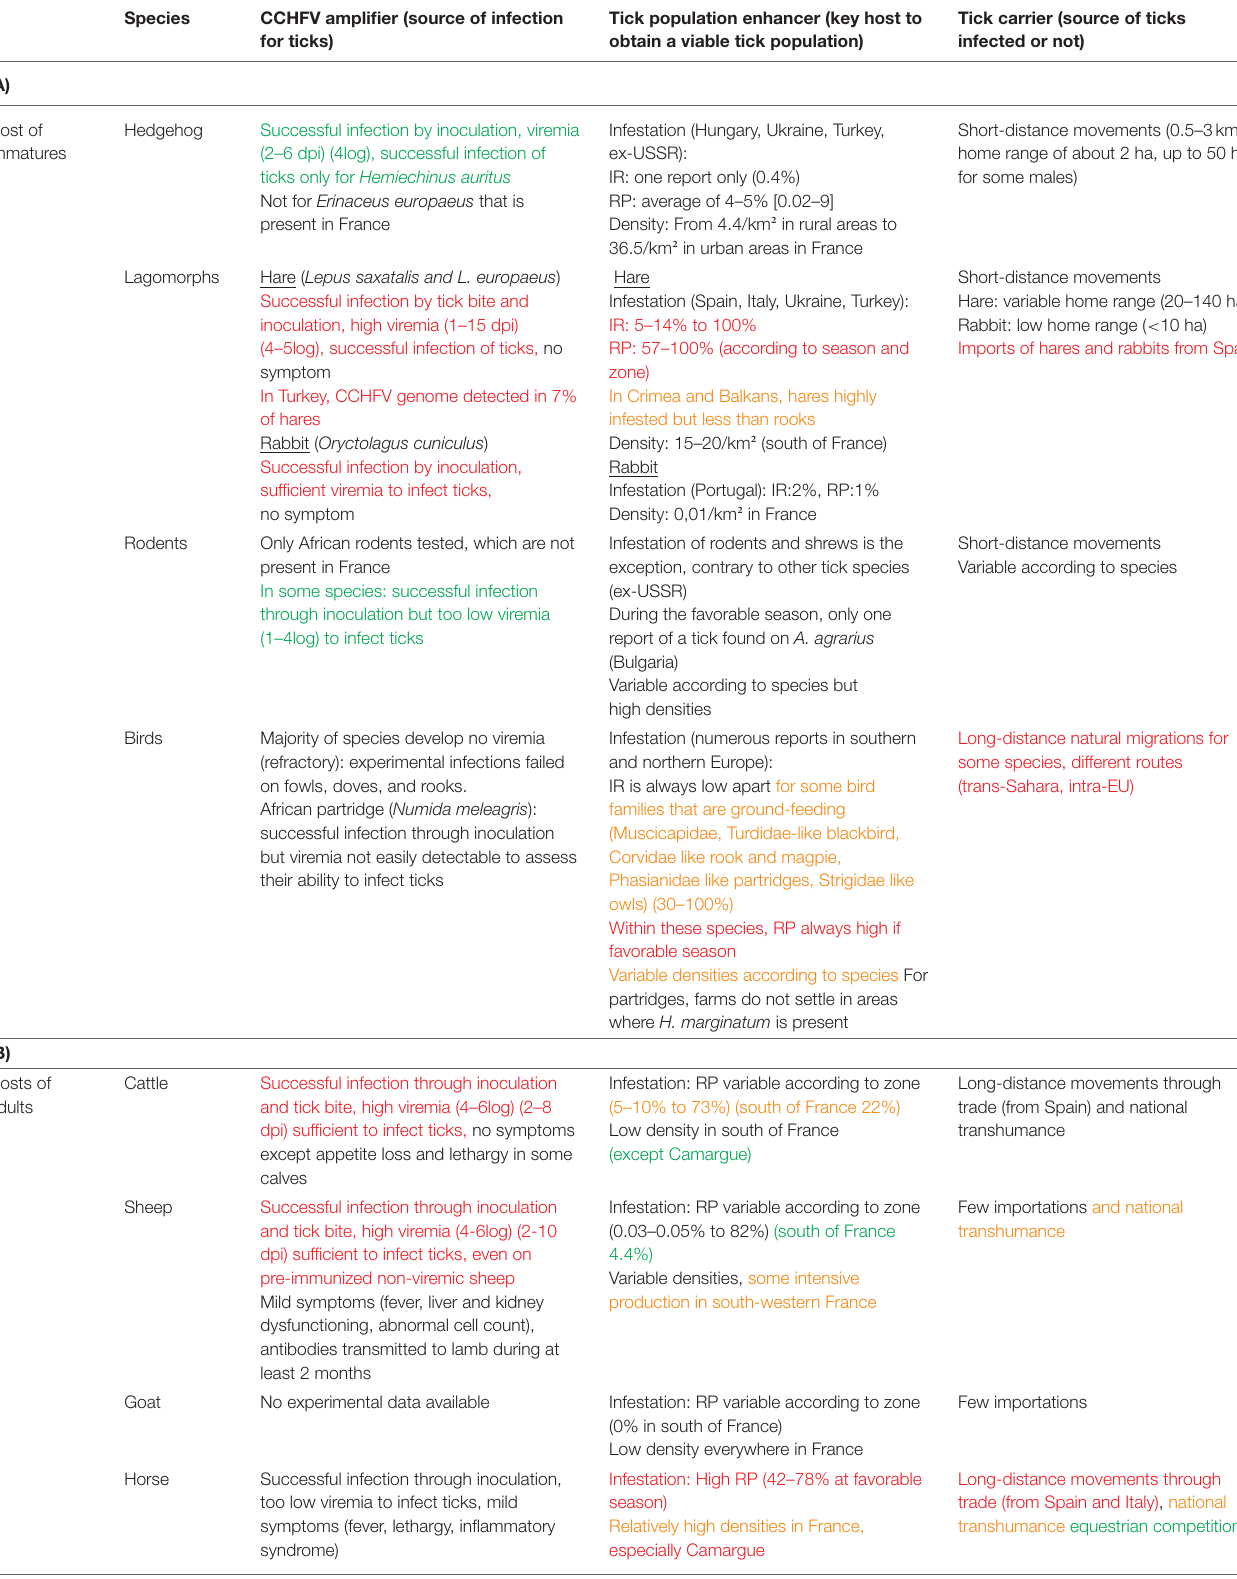
TABLE 2 | Candidate vertebrate hosts of H. marginatum and CCHFV that are present in France. Species CCHFV amplifier (source of infection for ticks)